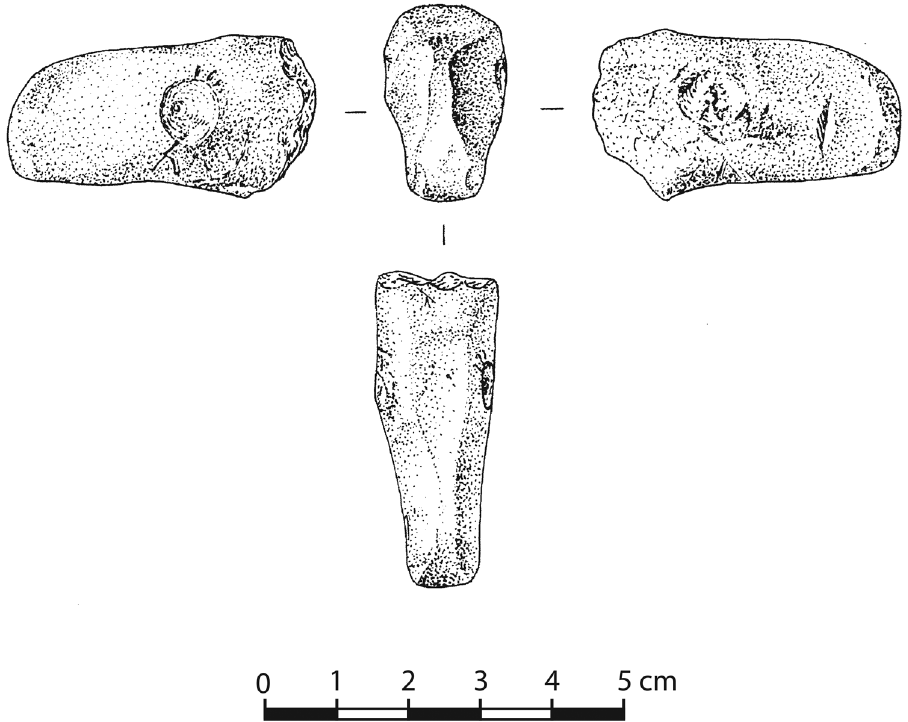
Figure 8: Figurine interpreted as a head of an elk, marked with eyes, eyebrows, and nostrils. Made from ceramics and retrieved at the Pitted Ware settlement site Solbakken 3, Ystehede, Halden County, Southeast Norway ( after Østmo, 2007 ) . Drawing: T. Strenger. Reprinted with kind permission from E.